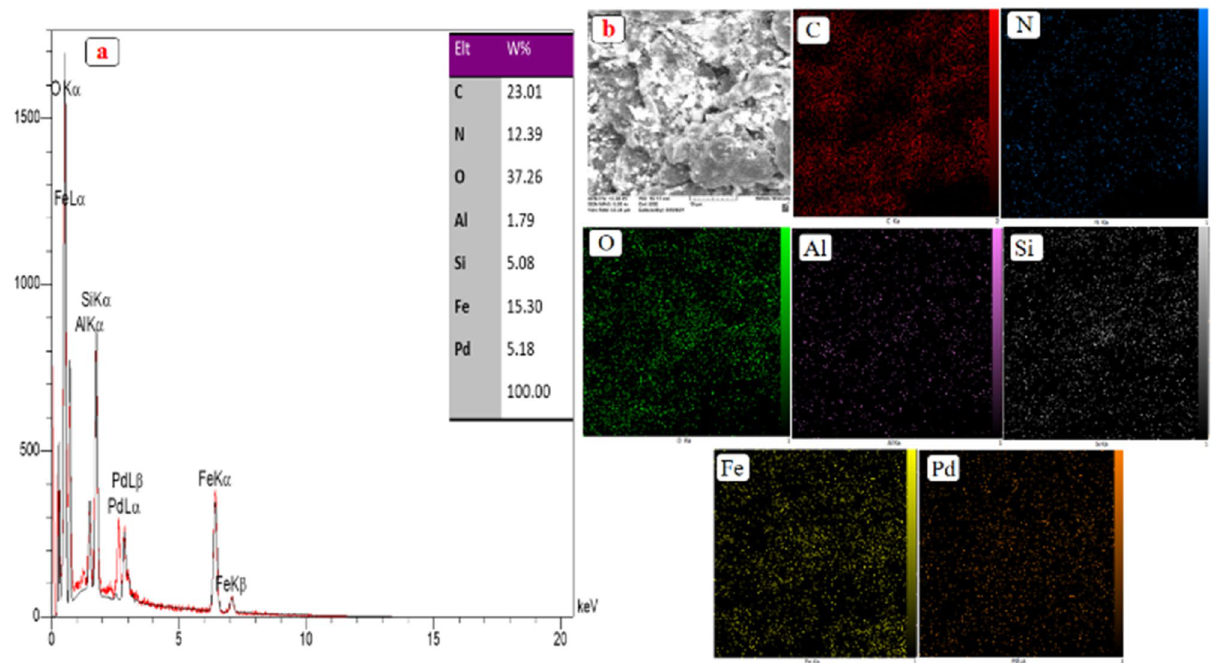
Figure 7. Corresponding EDX spectrum of Fe-Ben/PVP-DVB/Pd nanocatalyst ( a ), elemental mapping patterns of C, N, O, Al, Si, Fe, and Pd atoms ( b